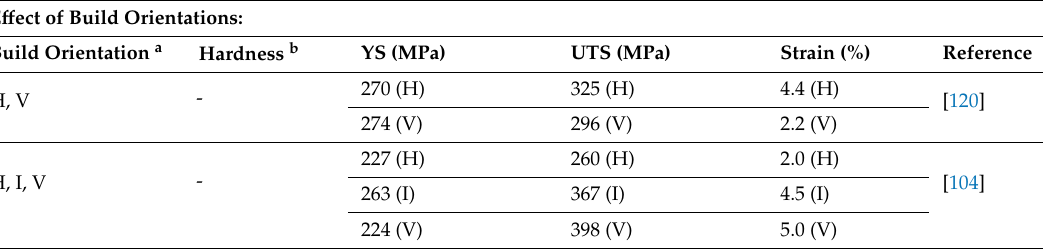
Table 5. Mechanical properties of SLM-printed AlSi 12